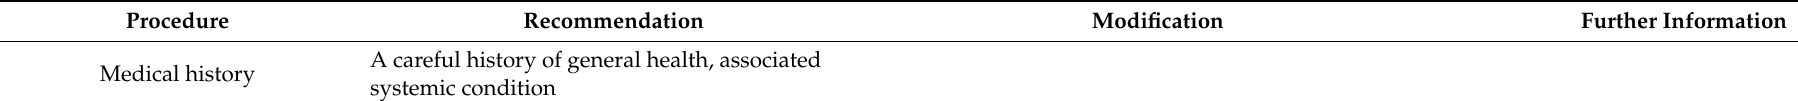
Table 1. A summary of recommendations related to the dental management of a child with hydrocephalus